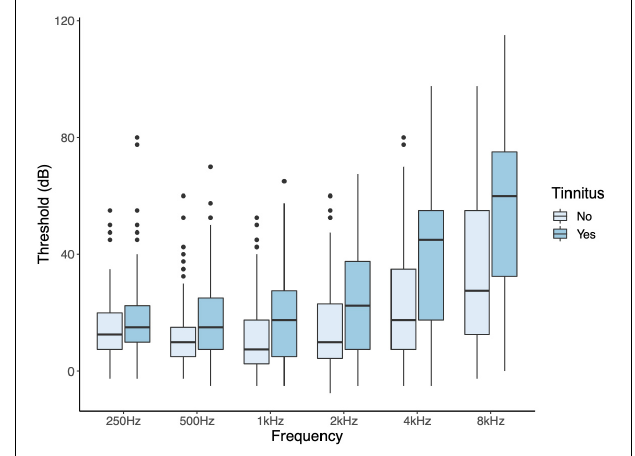
FIGURE 3 | Audiograms of participants with and without tinnitus. Hearing thresholds of the frequencies 0.5, 1, 2, 4, and 8 kHz were significantly higher in tinnitus participants compared to the control group after correcting for multiple